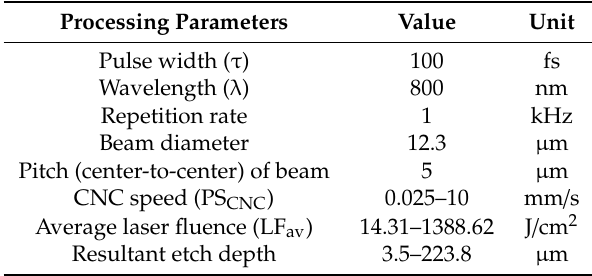
Figure 1. Schematic illustration of the femtosecond laser material processing (FLMP) setup. The path of the laser beam is fixed while the CNC stage allows XYZ θ motions. Table 1. Processing parameters used for FLMP of borosilicate glass substrate.